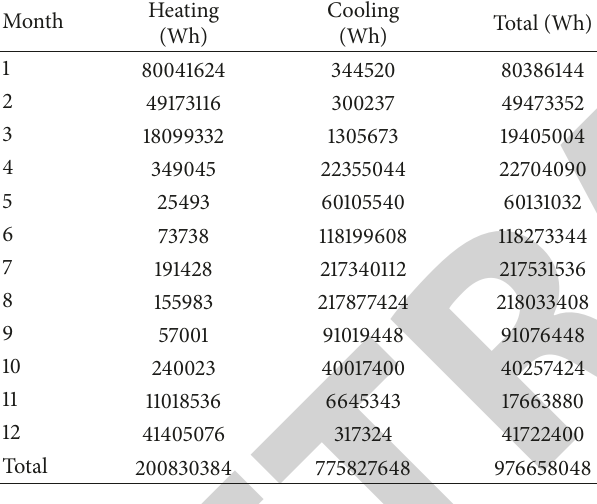
Table 7: Air conditioning energy consumption derived from the Ecotect